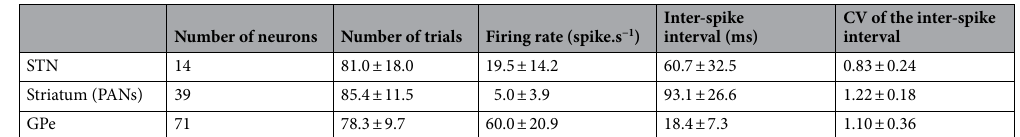
Table 1. Electrophysiological characteristics of the selected neuronal populations. Each row represents a structure of the basal ganglia (STN for Subthalamic Nucleus, PANs for the Phasically Active Neurons of the Striatum and GPe for the external segment of the globus pallidus). The columns show the number of neurons selected for the analysis, the number of trials during which they were recorded and the mean and standard deviation of their electrophysiological characteristics. The coefficient of variation of the inter-spike interval (ISI) was computed by dividing the standard deviation of the ISI by the mean of the ISI.